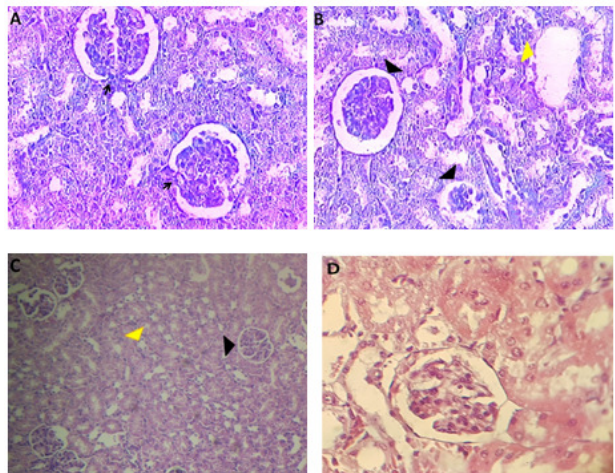
Figure 3. Section of renal rat tissue with hematoxylin and eosin (G:x20); (A) normal architecture and normal Bowman capsule ( ) in the control group (T) (Animals received distilled water) and the group MEO (D),(Animals received essential oil) ; (B) group (Mn-Pb), (Intoxicated animals) Showing degeneration of Bowman capsules ( ), with large interstitial spaces and complete absence of bypassed tubes ( ) ; (C) the group exposed to (Mn-Pb) and treated with essential oil, Showing the regeneration of the majority of Bowman's capsules ( ) and interstitial cells, with convoluted tubes ( )